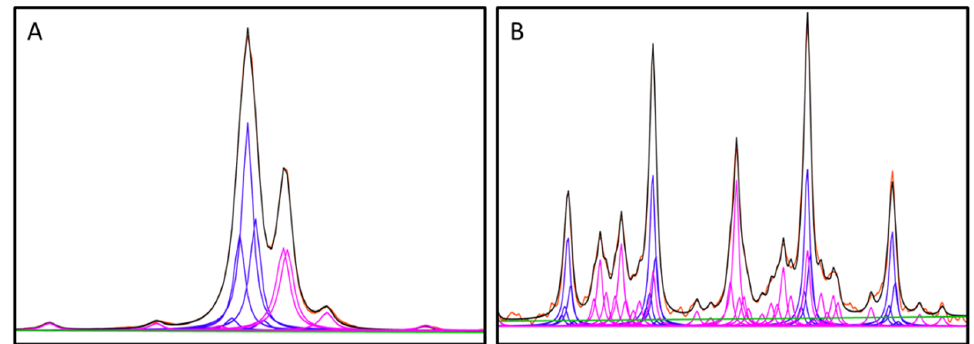
Figure 2. Overlays of observed NMR signal (red) and the mathematical model (black), along with analyte Lorentzian (blue), non-analyte Lorentzian (magenta) and linear baseline (green) components resulting from deconvolution of creatinine and citrate regions. ( A ): Creatinine region with nearby or overlapping signals. ( B ): Citrate region with nearby or overlapping signals.